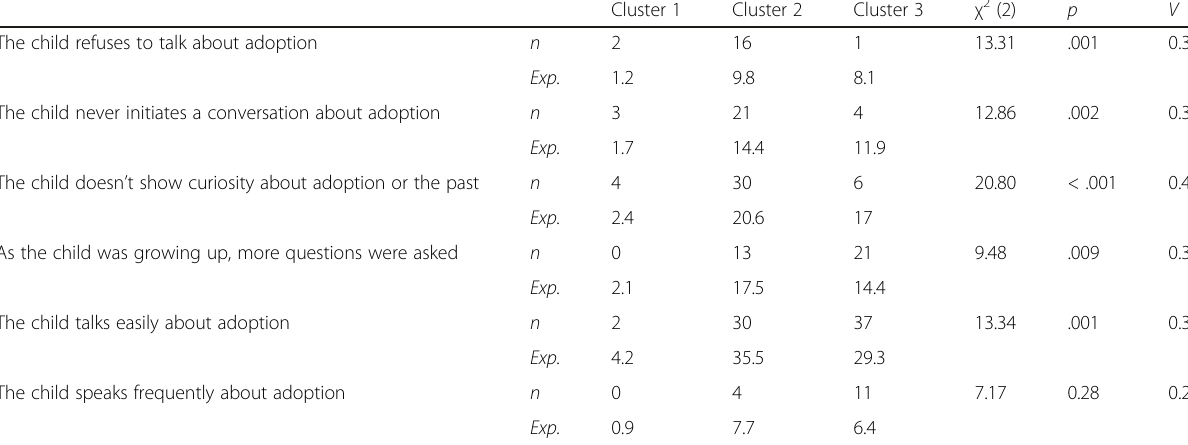
Table 4 Associations between Clusters and Child ’ s Behaviours towards Adoption